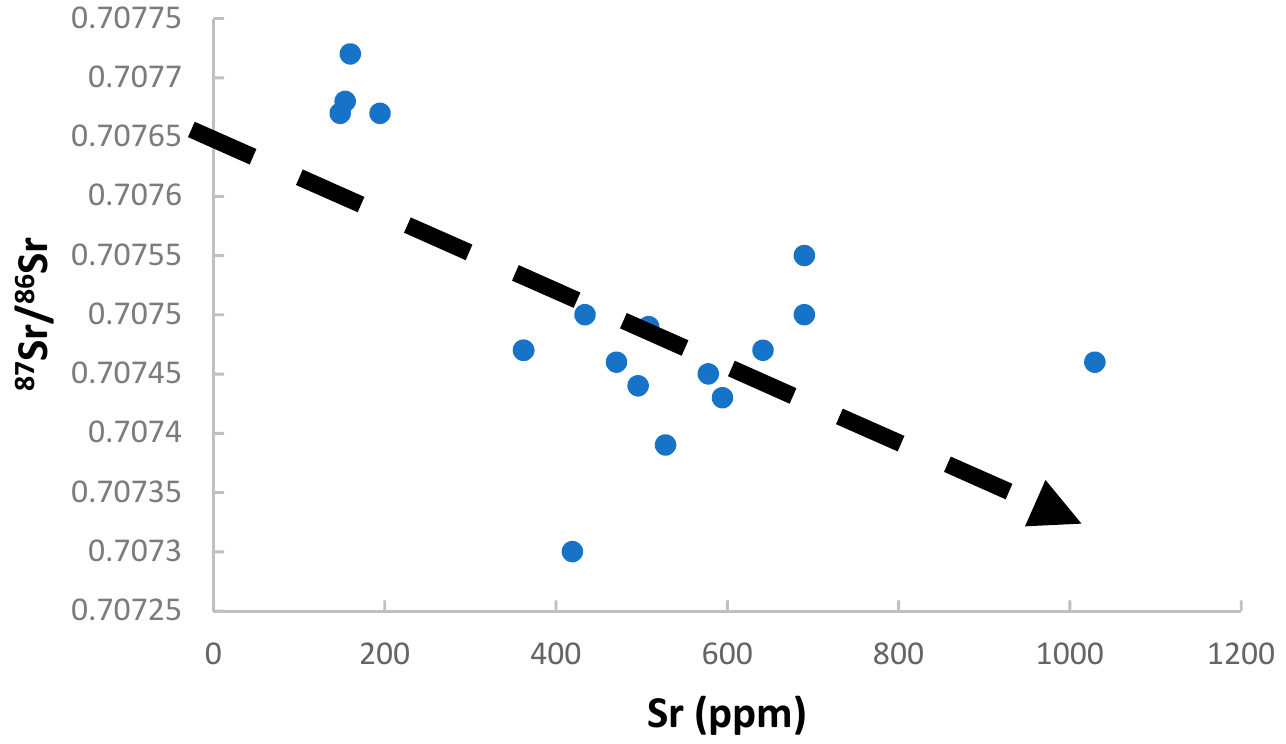
Figure 13. Strontium concentration v. 87 Sr/ 86 Sr ratios in diagenetic samples, the high strontium concentration is consistent with wide range of 87 Sr/ 86 Sr ratios, and the low strontium concentration is consistent with high 87 Sr/ 86 Sr ratios.